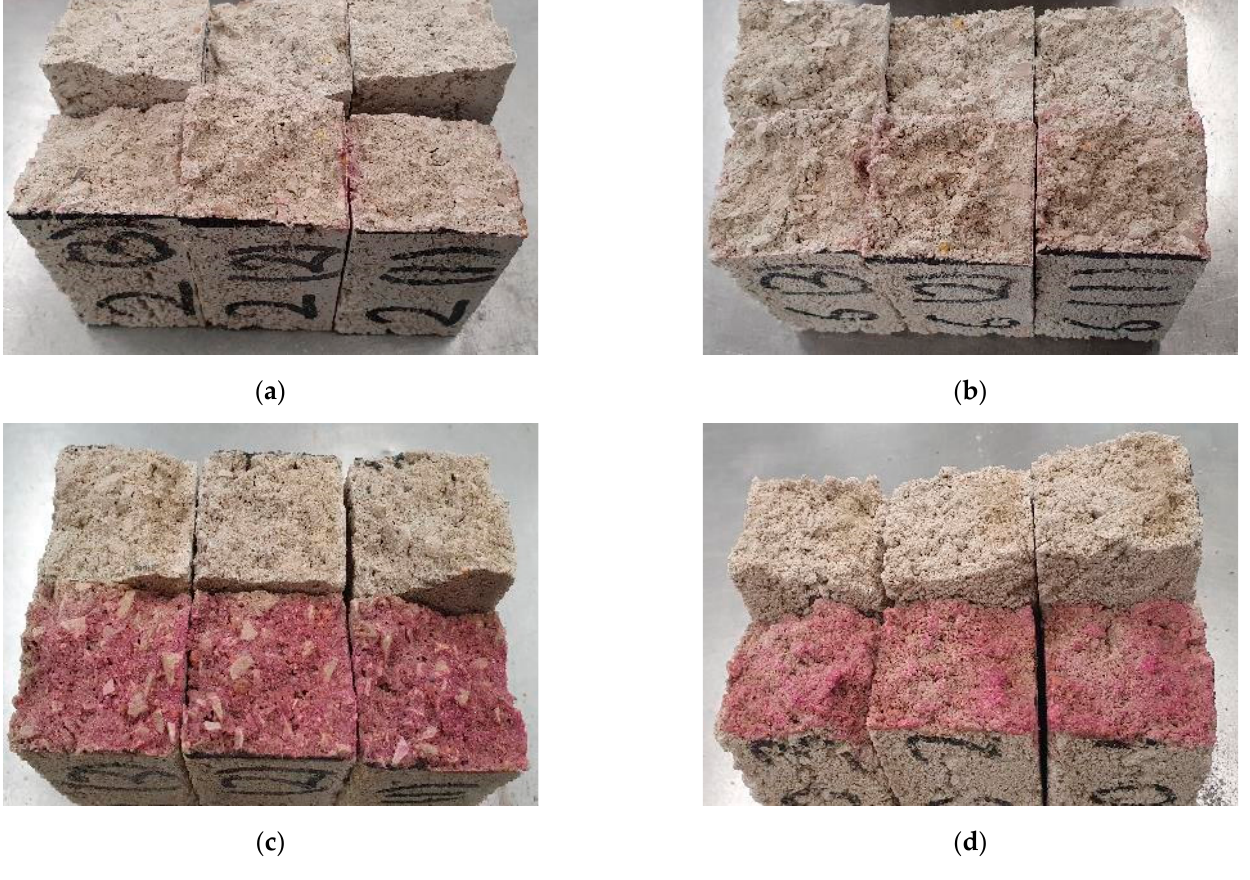
Figure 9 . The change in color by spraying phenolphthalein solution pH indicator on ( a ) N8S0.5, ( b ) N10S0.5, ( c ) N12S0.5, and ( d ) N14S0.5 WGR mixes. All precursors with a formulation of N12S0.5 and N14S0.5 showed significantly low cohesiveness. After having applied the phenolphthalein solution, the surfaces showed a pinkish hue. Generally, this indicates a low carbonation depth carbonation. However, this technique, which is normally used to measure the carbonation depth of OPC concrete, is not as accurate as when used on alkali-activated materials. Apart from observing a pH decline with ensuing carbonation, it also decreases with the ongoing chemical reactions between the precursor and the alkaline solution; the OH - ion in the pore solution, originally from the NaOH, is progressively embedded in the materials’ microstructure, namely in the formation of N-(C)-A-S-H phases. Therefore, the phenolphthalein solution pH indicator is not valid in establishing the front of carbonation in AAMs, but it can be used to ascertain the extent of OH - taken up by reaction products and thus an indicator of the material’s performance. Previous studies have demonstrated the positive impact of an accelerated carbonation curing stage on the strength development of alkali-activated concretes, by comparing uncarbonated specimens with carbonated ones with the same mix design [89]. During this stage, Ca-bearing phases become decalcified with ongoing exposure to a CO 2 - rich environment, leading to the formation of CaCO 3 and amorphous Si—O structures [90]. Consequently, microstructural densification occurs leading to enhancement in mechanical performance including compressive strength [28,38–44]. As expected by the authors’ previous experience on the matter, FA mixes show greater enhancements in performance when compared to MIBA, EAFS, and WGR, as it contains more reactive amorphous aluminosilicate phases resulting in the creation and growth of the amount of N–A–S–H [89,91]. In addition, the FA’s specific morphology allows for a more enhanced compaction of the material, creating a denser microstructure. Nevertheless, it is worth